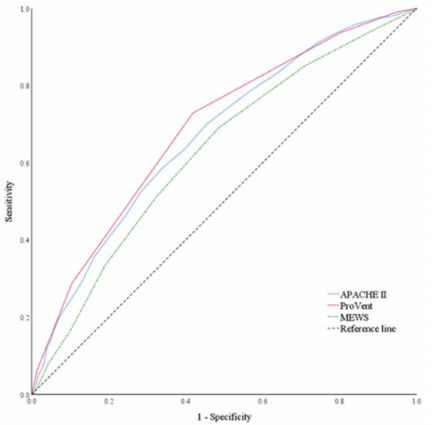
Figure 2. Receiver operating characteristics curves showing the performance of APACHE II (AUC: 0.67, 95% CI: 0.65–0.69), ProVent (AUC: 0.69, 95% CI: 0.67–0.71), and MEWS (AUC: 0.63, 95% CI: 0.60–0.65) for predicting 30-day mortality in mechanically ventilated patients, in the test set. APACHE, Acute Physiology and Chronic Health Evaluation; AUC, area under the curve; MEWS, Modified Early Warning